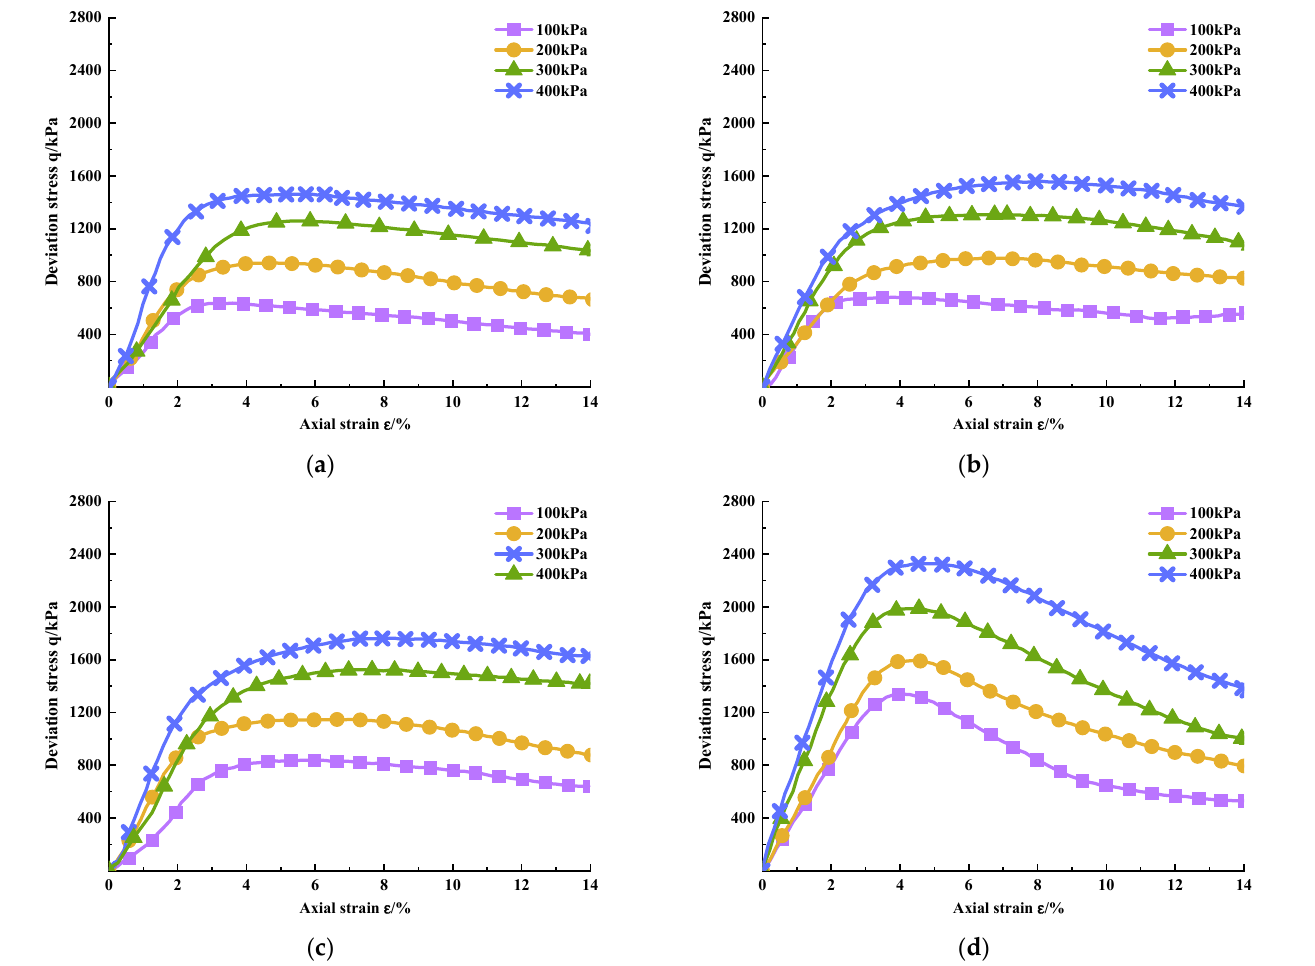
Figure 5. Deviatoric stress–strain curves of PURD at 28 days curing time. ( a ) PURD-3; ( b ) PURD-4; ( c ) PURD-5; ( d ) PURD-6.